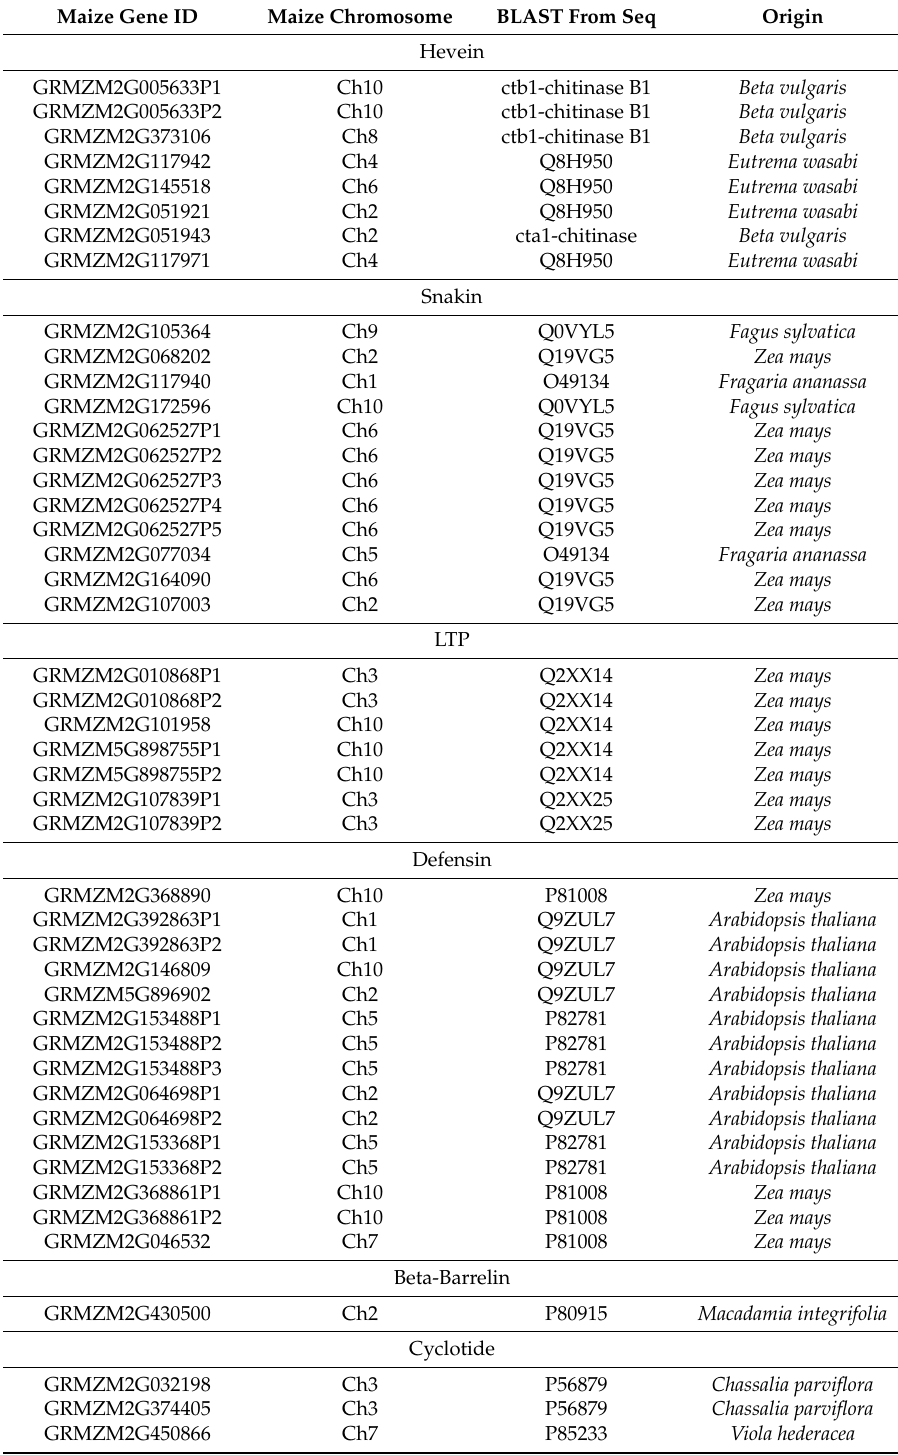
Table 1. Maize antimicrobial peptides (AMP) genes identified by basic alignment search tool (BLAST) maize B73 genome with known plant AMP sequences from various